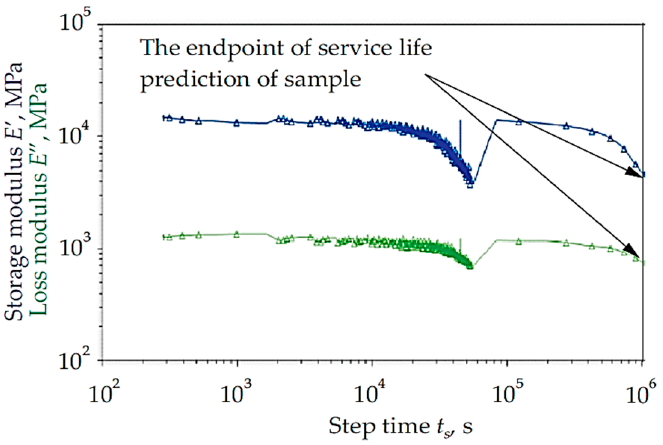
Figure 9. Master curve of both pGFRP composite samples at 95 °C, which indicates 25 years of ser- vice [94]. service [94].